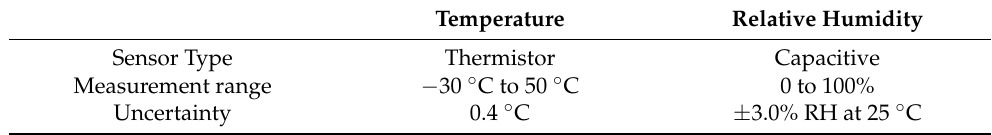
Table 1. Technical features of the T and RH sensors (Tinytag View 2 TV-4050) used in the monitoring. Temperature